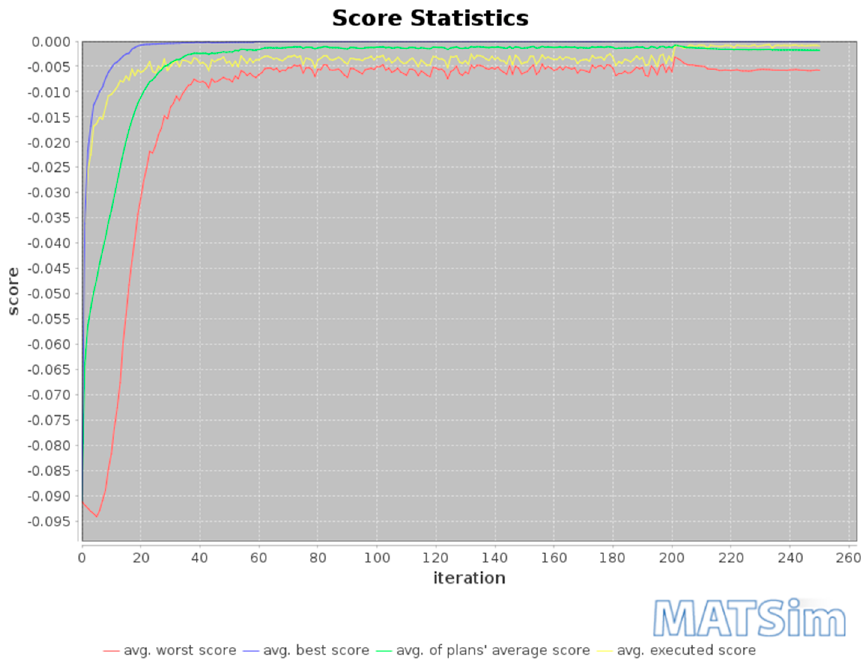
Figure 9. MATSim simulation scores statistics.